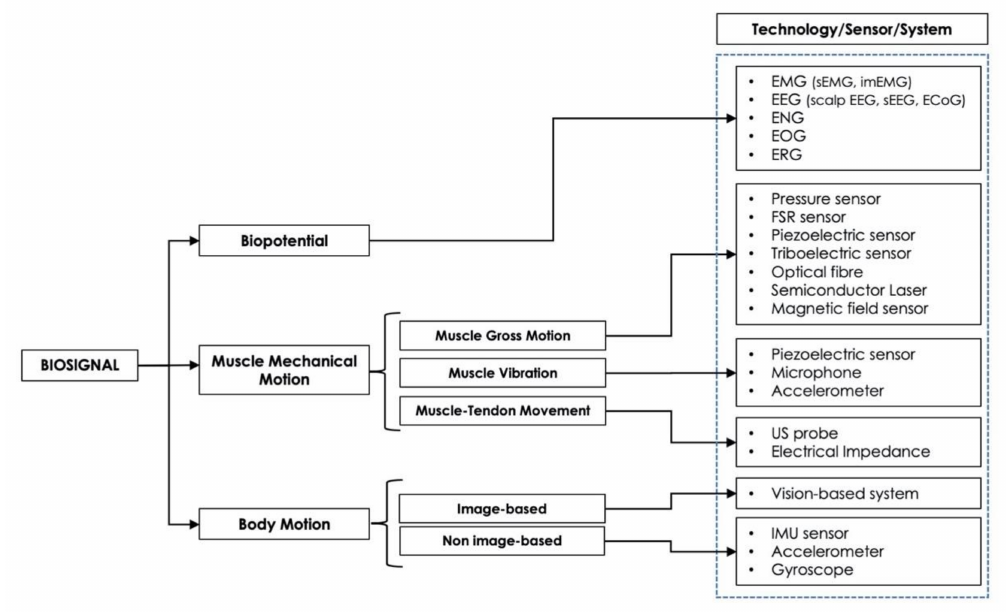
Figure 5. Types of biosignal and main technologies/sensors/systems used by assistive and/or rehabilitative